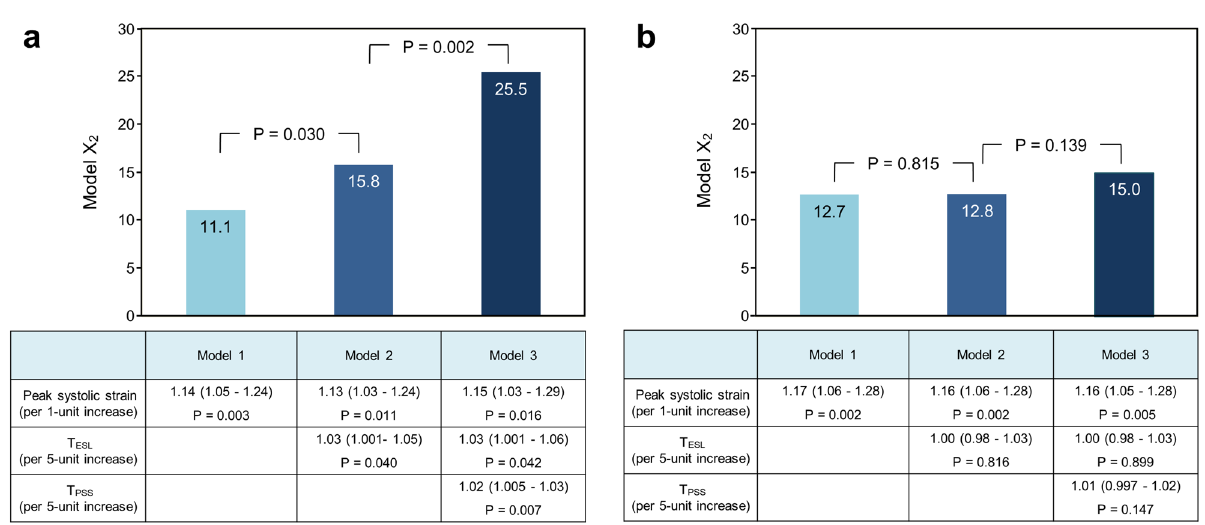
Figure 2. Peak systolic strain, T ESL , and T PSS in the three groups. In the single-vessel group, the absolute value of the peak systolic strain was significantly lower, and T ESL and T PSS were significantly longer than those of the no stenosis group. In the multivessel group, the peak systolic strain was also significantly lower. T ESL and T PSS tended to be prolonged but not to a statistically significant degree. * P < 0.05 versus the no stenosis group. † P < 0.01 versus the no stenosis group.